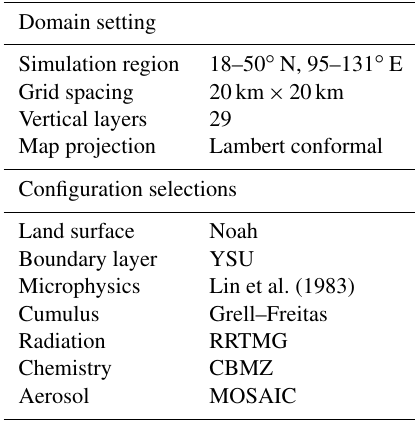
Table 2. WRF–Chem domain setting and configuration selection. Domain